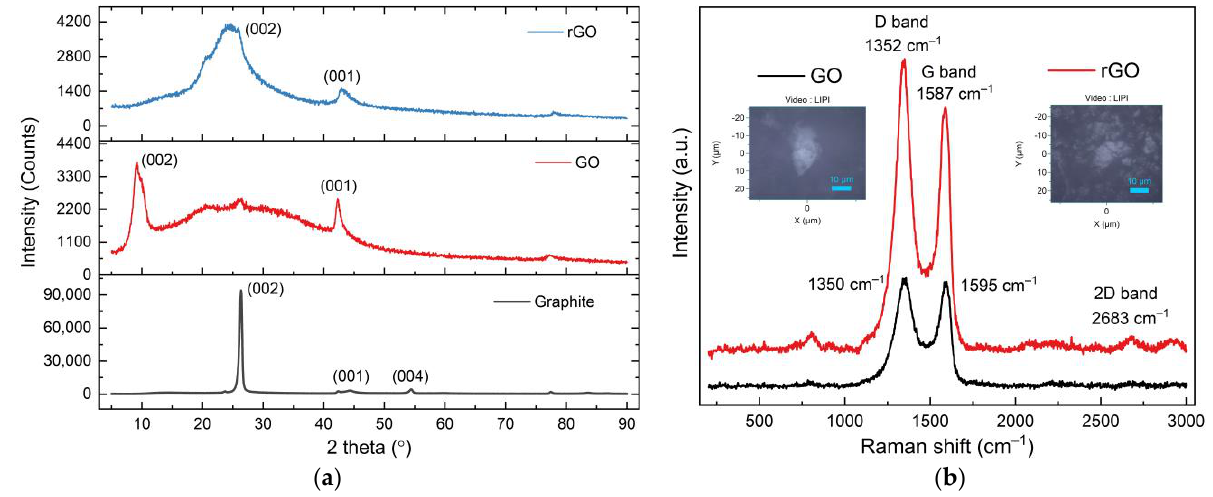
Figure 5. ( a ) Diffractogram of graphite, GO, and rGO. The transformation of graphite into GO and rGO shifted the planes (001), (002), and (004) and ( b ) Raman spectra of GO and rGO showing the peak locations of Dband and Gband.